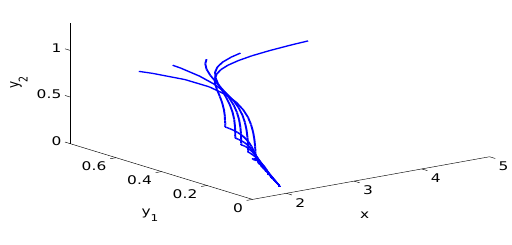
Figure 4: µ = 1 , τ = 10 , E 1 = (2, 0, 0) of system (1.4) with different initial values is globally asymptotically